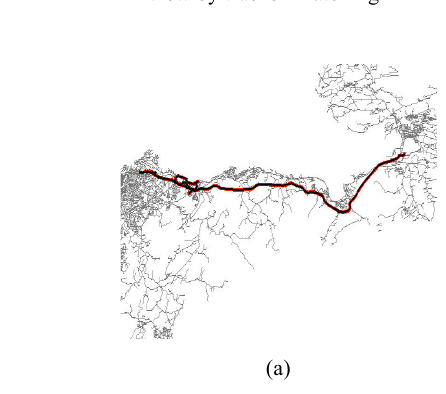
Figure 3 The overall view and a partial enlarged view by tracks1